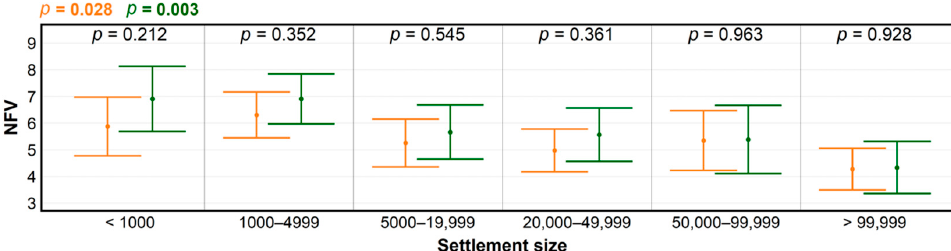
Figure 3. Levels of significance for differences in numbers of forest visits (NFV) according to settlement size, before (orange) and during the COVID-19 pandemic (green), produced using ANOVA; and for NFV differences within groups (black), determined by t -test.